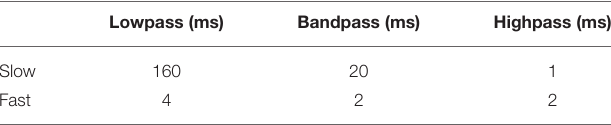
TABLE 1 | Smoothing time constants for the low-, band-, and highpass-filtered signals used for acoustic onset detection. Lowpass